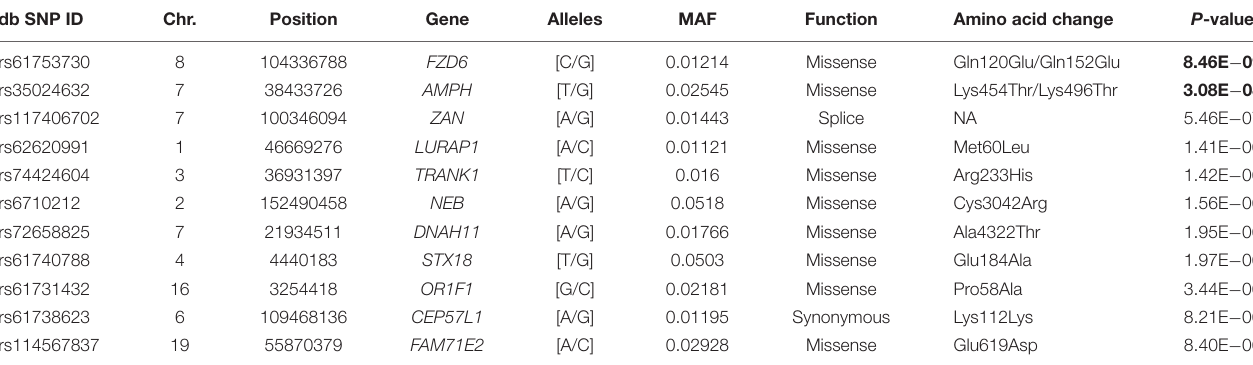
TABLE 1 | A list of top 11 single nucleotide polymorphisms (SNPs) with p < 1 × 10 − 5 resulted from genome-wide association analysis.